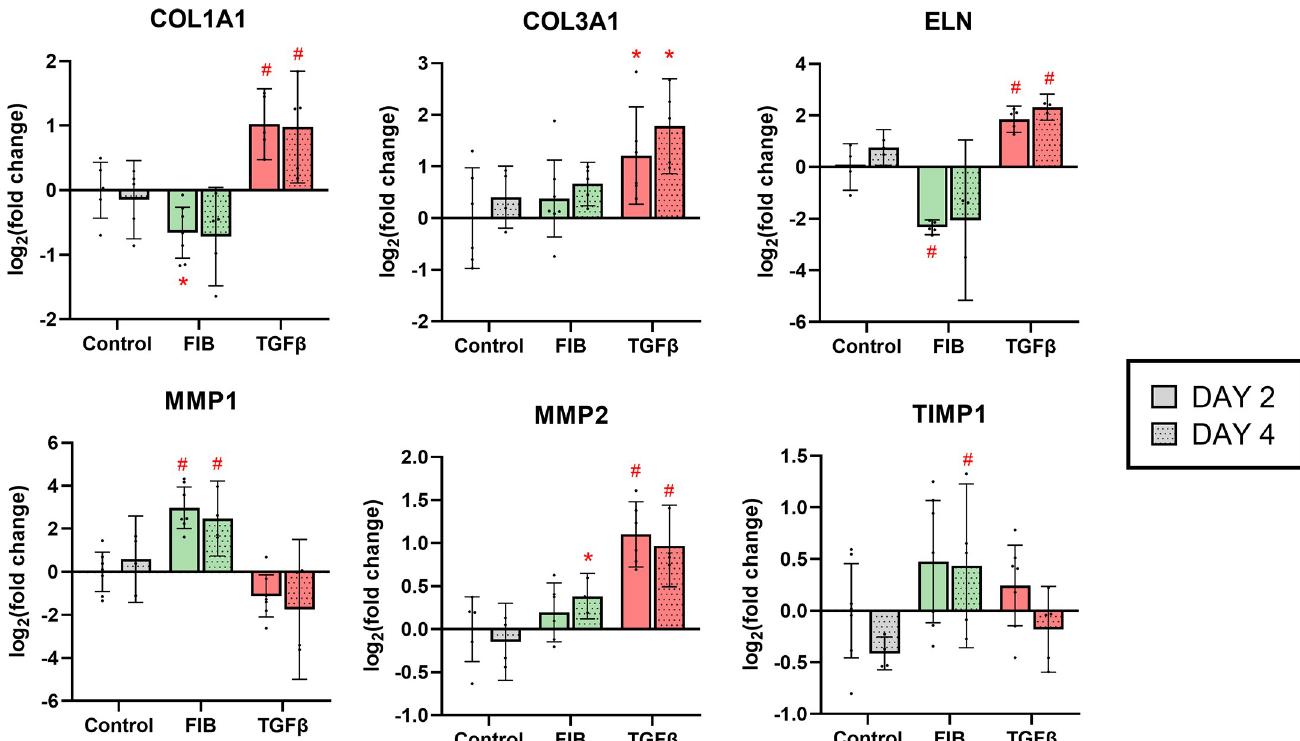
Fig 9. FGF-2 promotes matrix breakdown expression pattern. RT-qPCR results on a panel of matrix associated genes. � p < 0.05, #p < 0.01, dots represent biological replicates (n = 7 on day 2, n = 5 on day 4), error bars represent 95% CI.